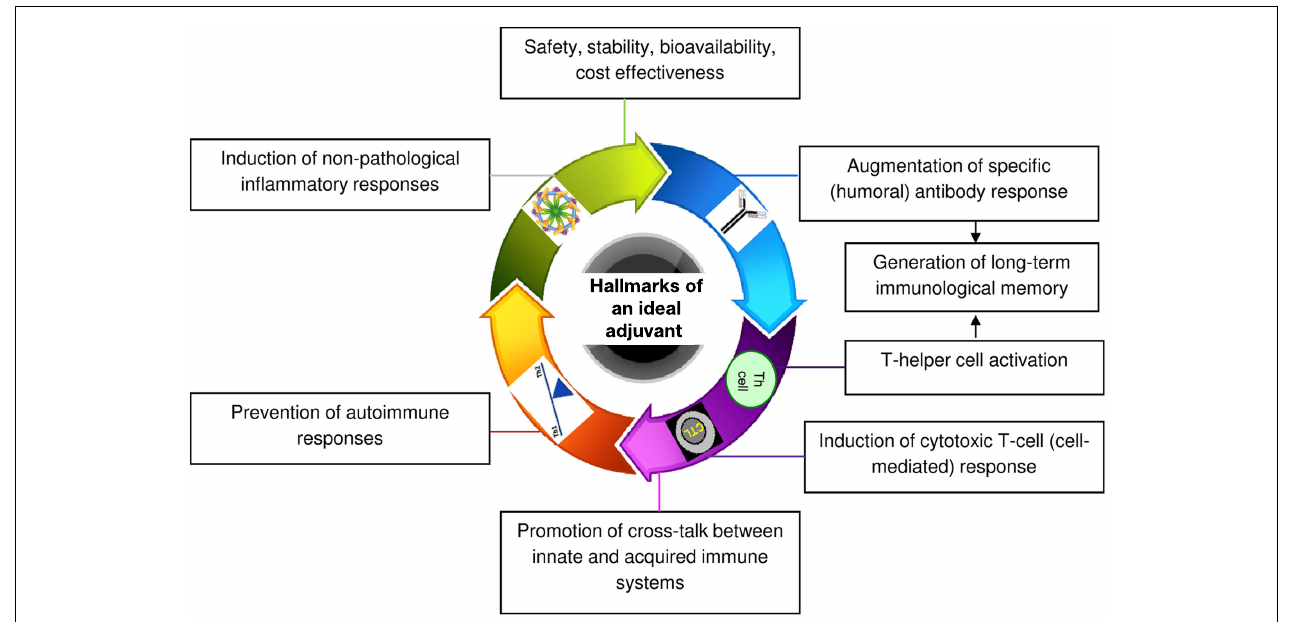
FIGURE 1 | Schematic diagram showing eight hallmark features of an ideal adjuvant.